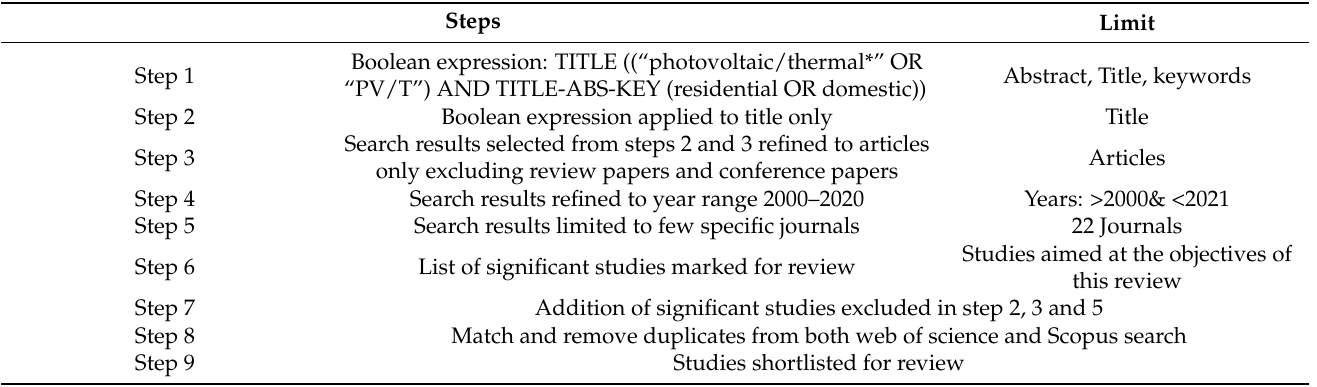
Table 1. Stepwise methodology for literature